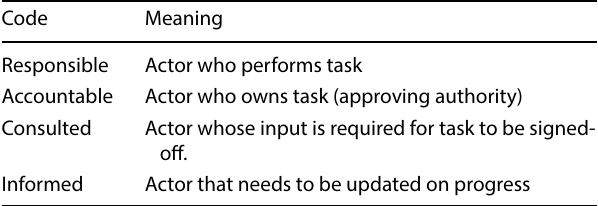
Table 9 R-A-C-I